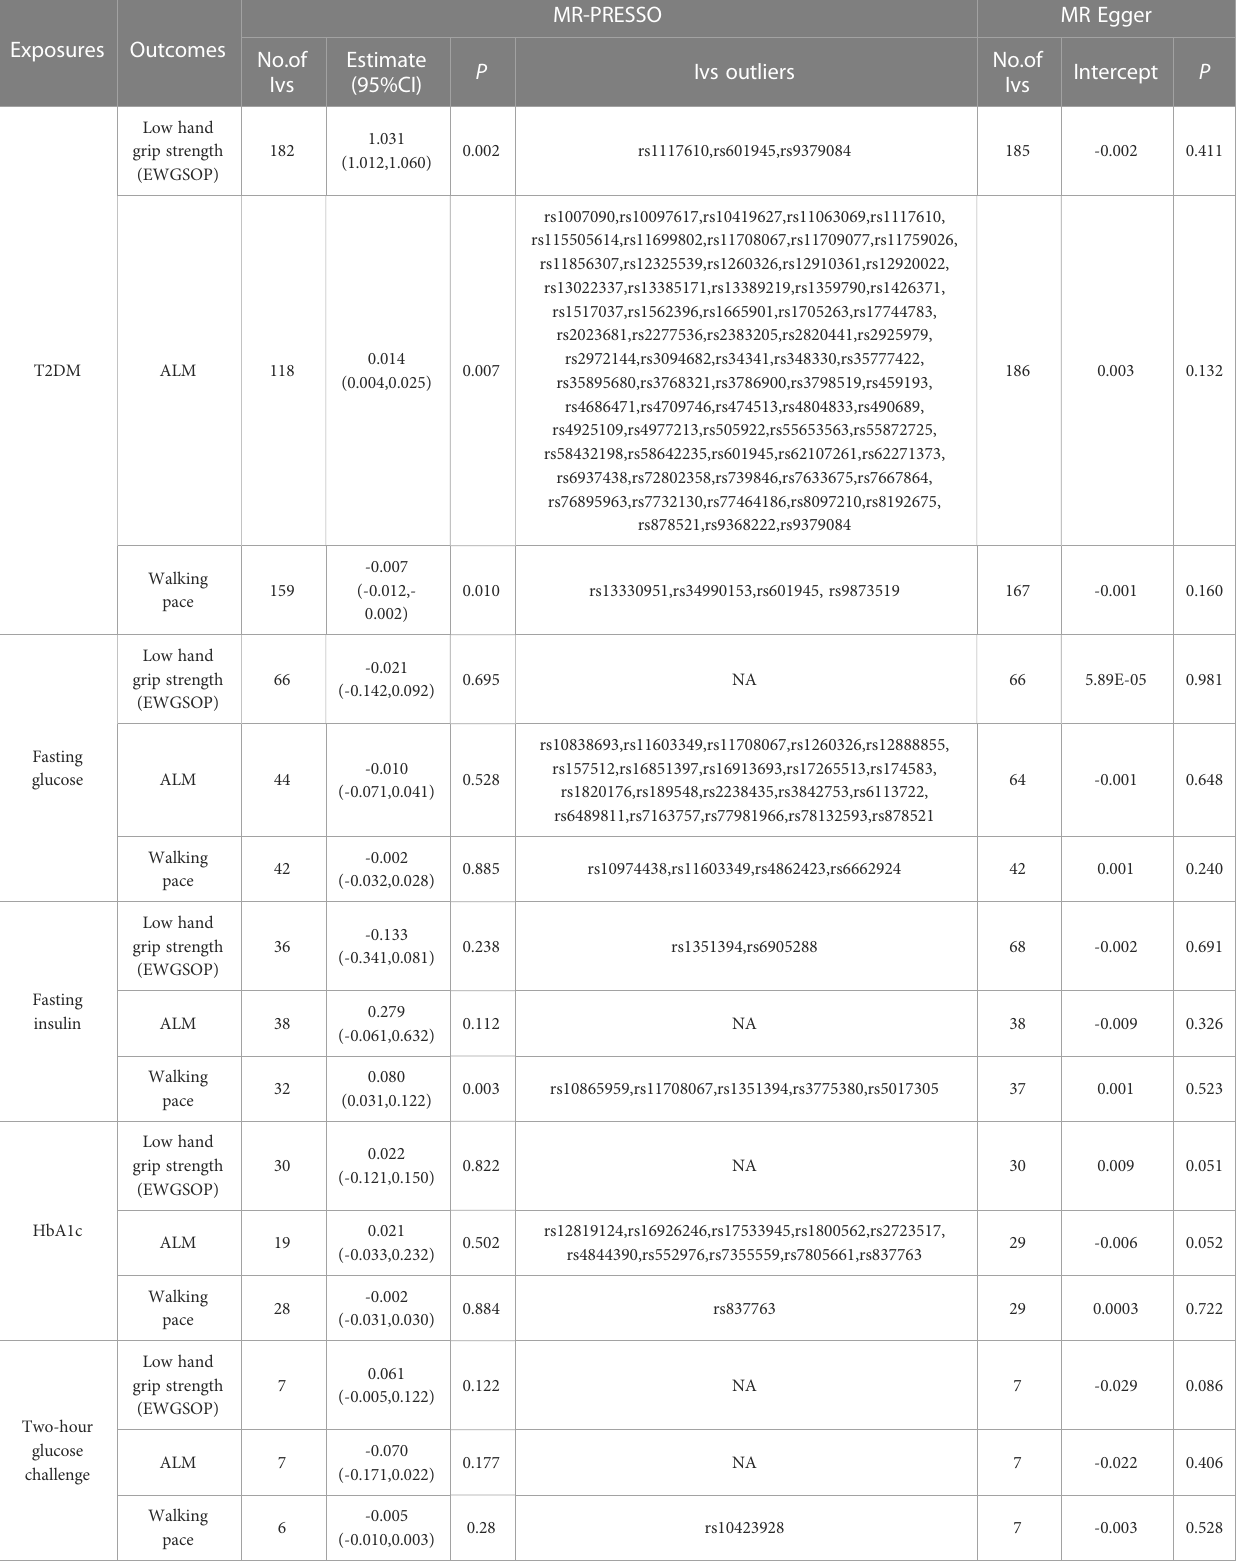
TABLE 7 Association T2DM and glycaemic traits with sarcopenia-related traits using MR-PRESSO and MR Egger.